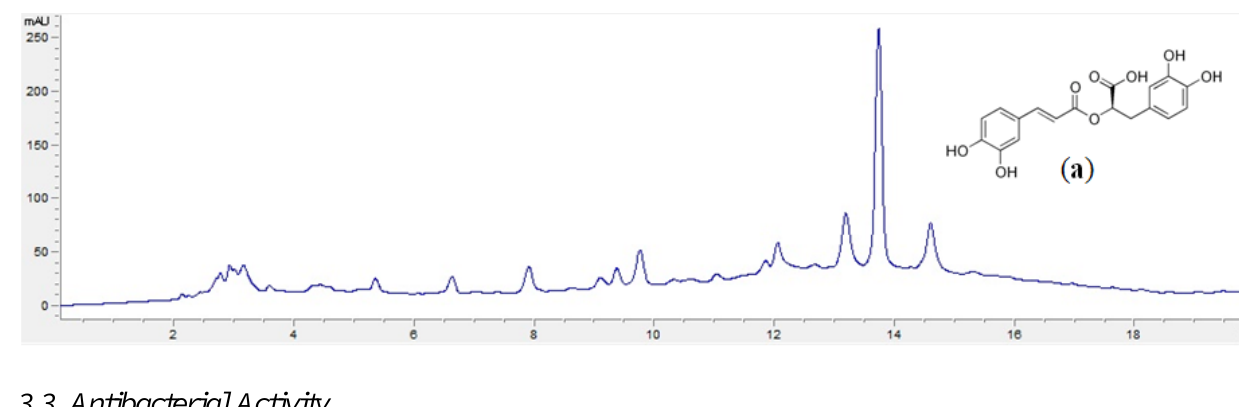
Figure 1. Example of a chromatogram of P. madagascariensis extract (5 mg/mL) obtained by the microwave technique. ( a ) Rosmarinic acid